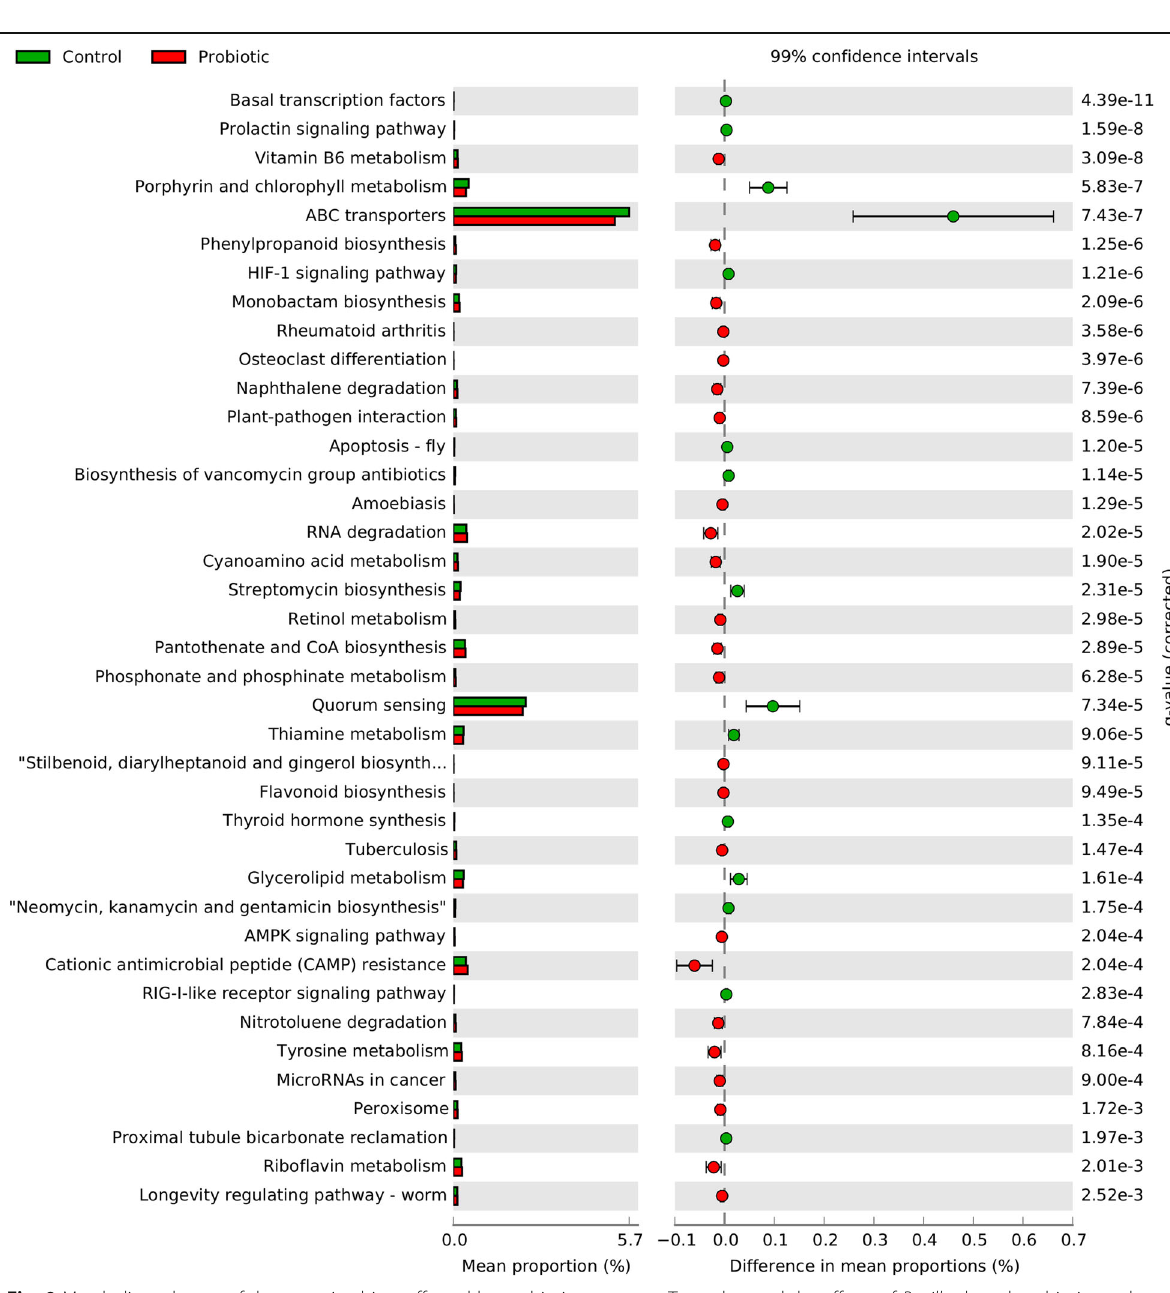
Fig. 9 Metabolic pathways of the gut microbiota affected by probiotic treatment. To understand the effects of Bacillus based probiotic on the differential abundance of metabolic pathways of the gut microbiota, the functional prediction data obtained through Tax4Fun2 were analysed in STAMP by using Welch ’ s t test with 99% confidence interval. For multiple test correction in STAMP, Benjamini-Hochberg was used with a q-value filter > 0.05 that resulted only in the features that were significantly different between the two treatment groups. The remaining significantly enriched metabolic pathways belonging to Fig. 9 have been visualised in Additional file 11: Fig.